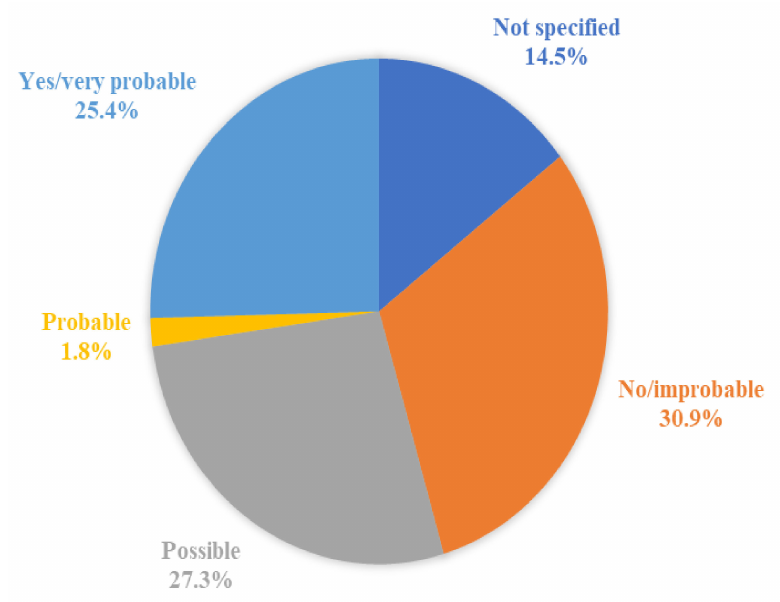
Figure 4. The distribution of the probability of the causal relationship among the 55 cases of death after the vaccination.